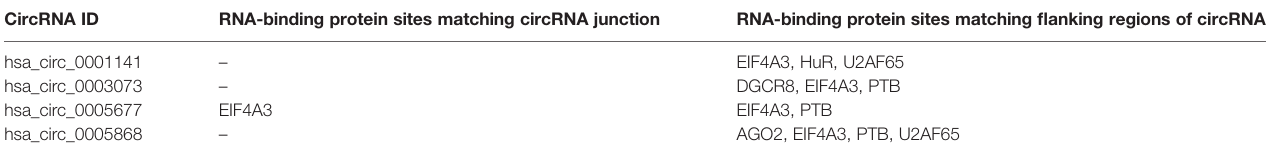
TABLE 4 | Possible interactions between circITCH and RNA-binding